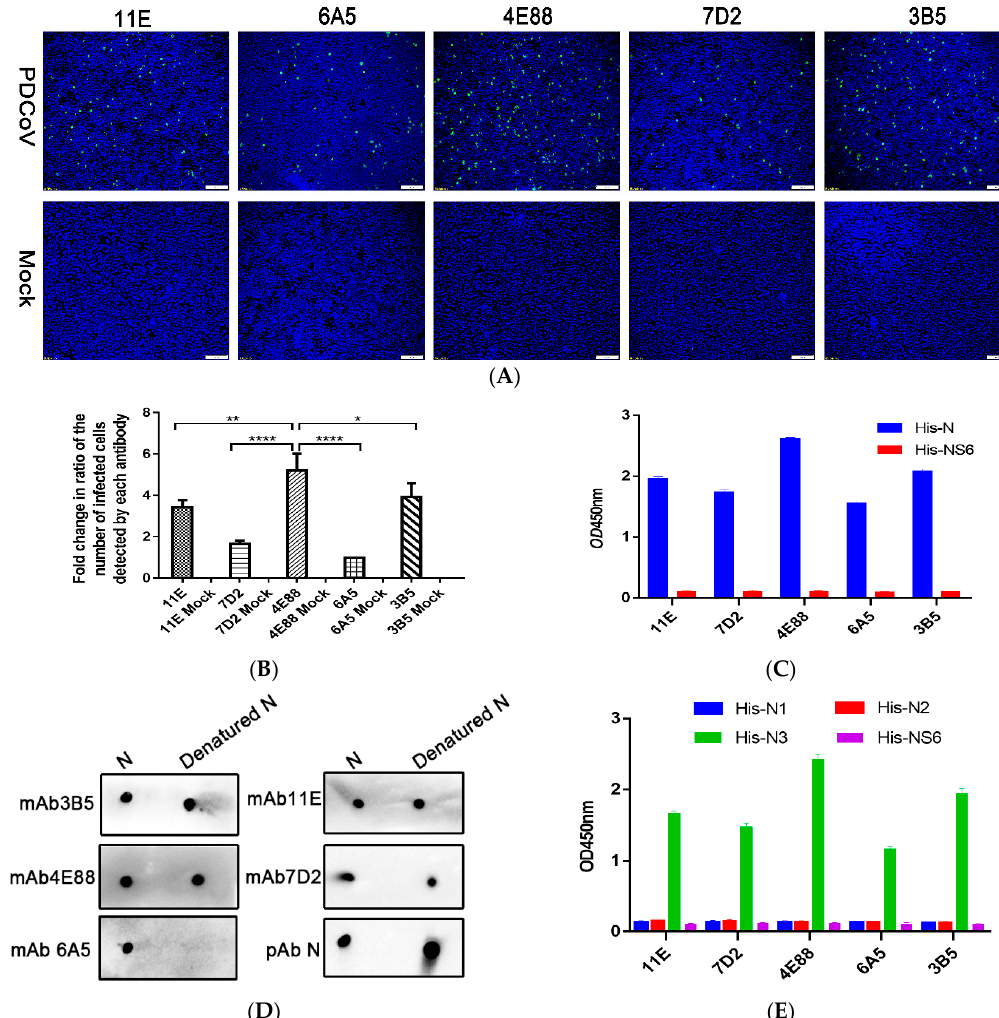
Figure 2. Activity of anti-PDCoV rNP mAbs. ( A ) Immunoinfluscent assay (IFA) of the five mAbs in PDCoV infected cells. Magnification = 10×; ( B ) Quantification of the virus-infected cells detected by each monoclonal shown in panel A. * p = 0.0483, ** p = 0.0049, **** p < 0.0001 for 4E88 compared to 3B5, 11E, 7D2, 6A5, respectively; ( C ) Activity of the antibodies with His-N and His-NS6 by ELISA; ( D ) Linear epitope identification of five monoclonals by dot blot with denatured and native N protein; ( E ) ELISA assay of the reactivity of each monoclonal with the N1,N2, and N3 protein. The experiments were repeated three times.